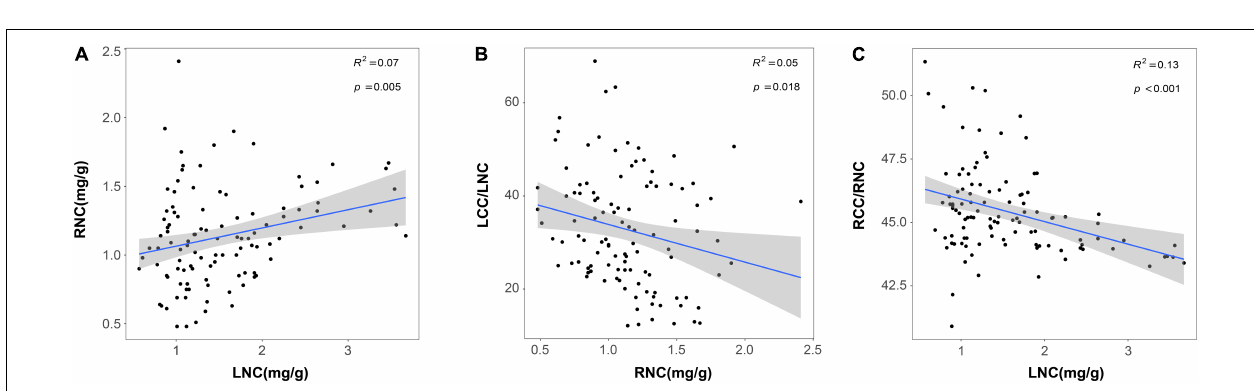
FIGURE 2 | Effects of nitrogen addition on plant functional traits [ (A,B) for PC of aboveground and (C,D) for PC of belowground]. The R 2 (coefficient of determination) and p -values are obtained from the linear regression analyses. Shaded areas show 95% confidence interval of the fit test.